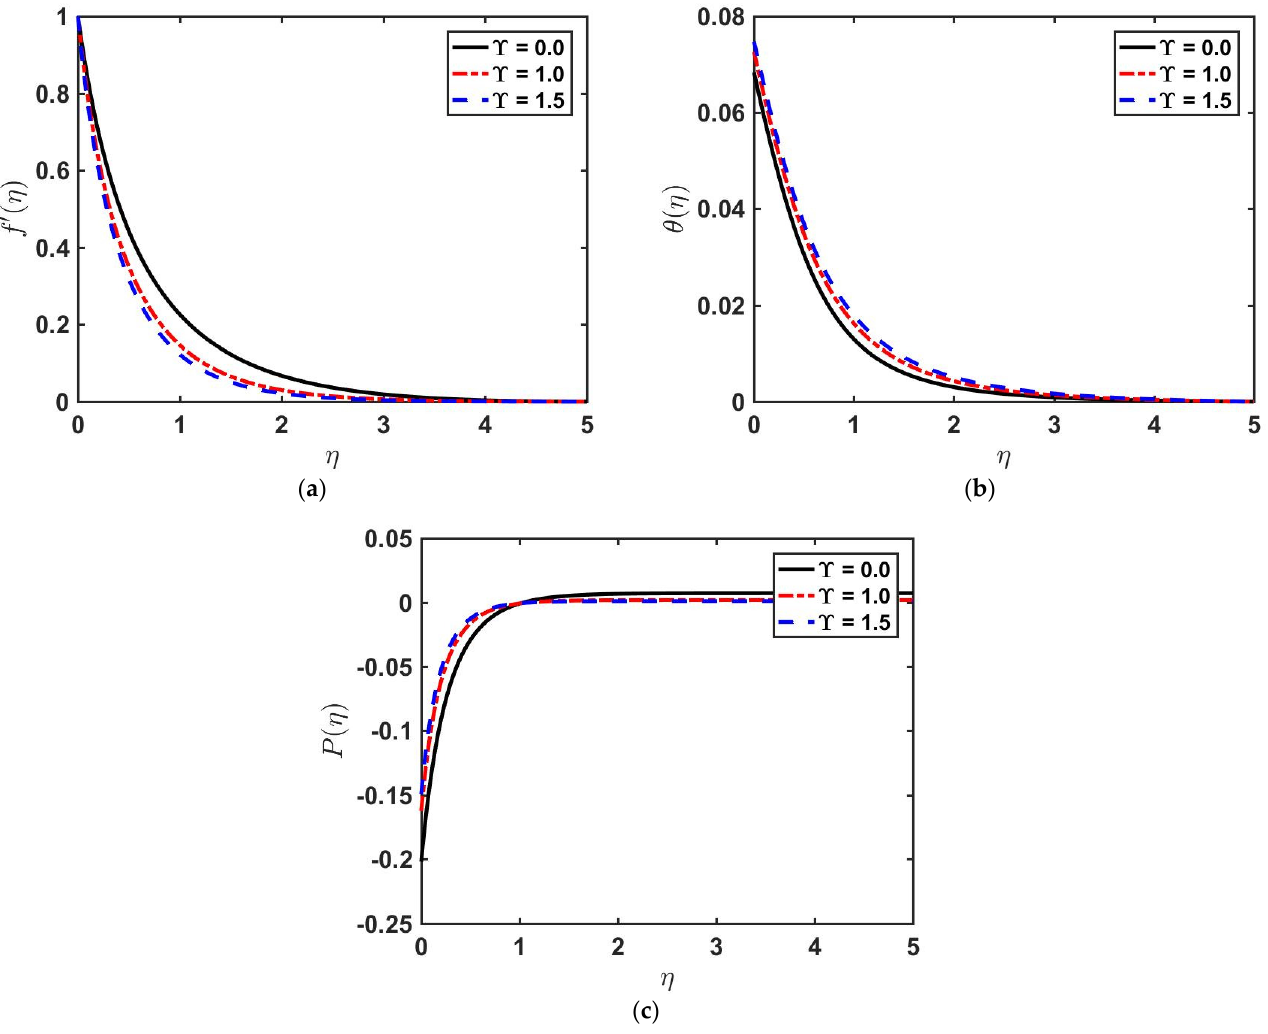
Figure 13. Effect of 𝚼 on ( a ) 𝒇′(𝜼) , ( b ) 𝑷(𝜼) , and ( c ) 𝜽(𝜼)) .